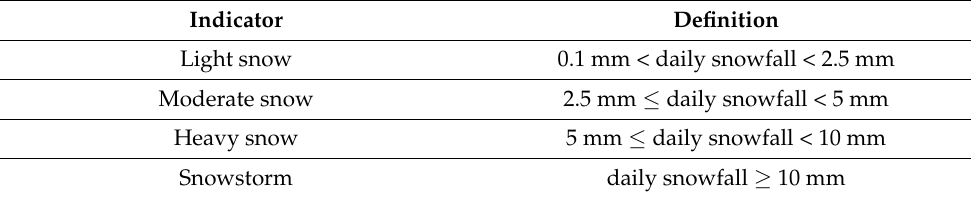
Table 2. Definition of the snowfall